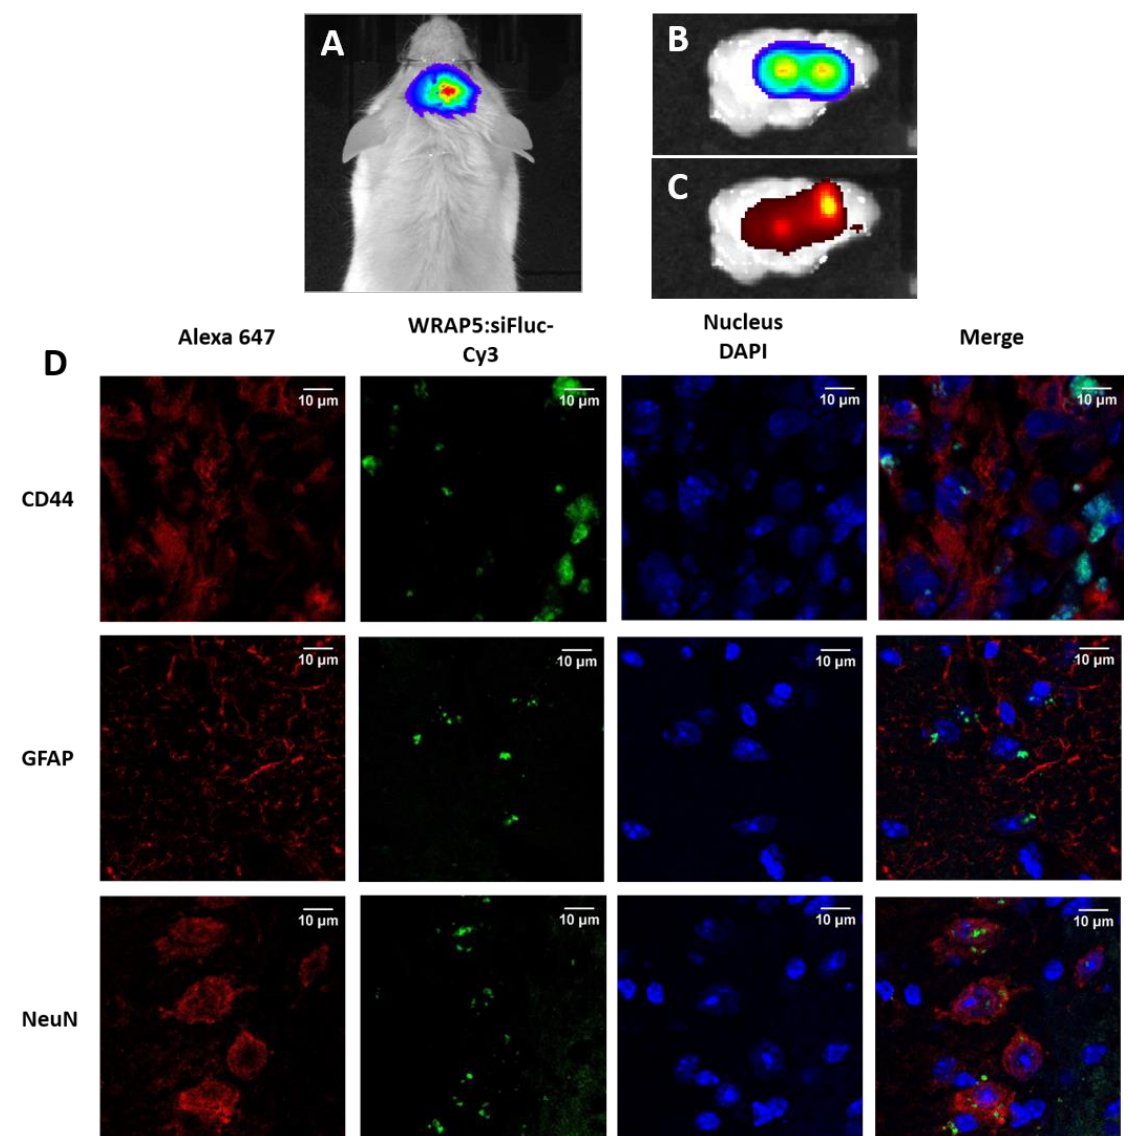
Figure 3. Cellular uptake of WRAP5:siFluc-Cy3 PBNs on U87 orthotopic tumor. ( A ) Bioluminescence imaging (BLI) of a mouse bearing an orthotopic tumor. ( B , C ) BLI and FRI, respectively of the excised brain 8 h after WRAP5:siFluc-Cy3 PBNs injection. ( D ) Immunofluorescence images on cryosections (10 µ m). The proteins GFAP, NeuN, and CD44 revealed with an Alexa647 secondary antibody are shown in red. The WRAP5-siFluc attached to the fluorophore Cy3 is shown in green, and the nucleus stained in blue with